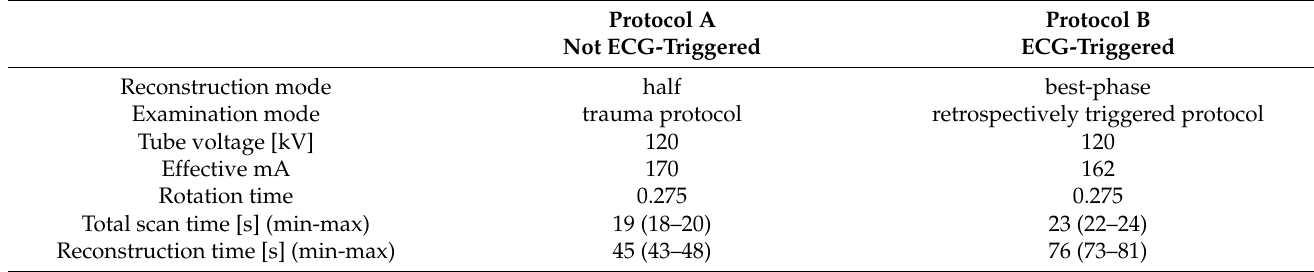
Table 1. Overview of computed tomography protocol